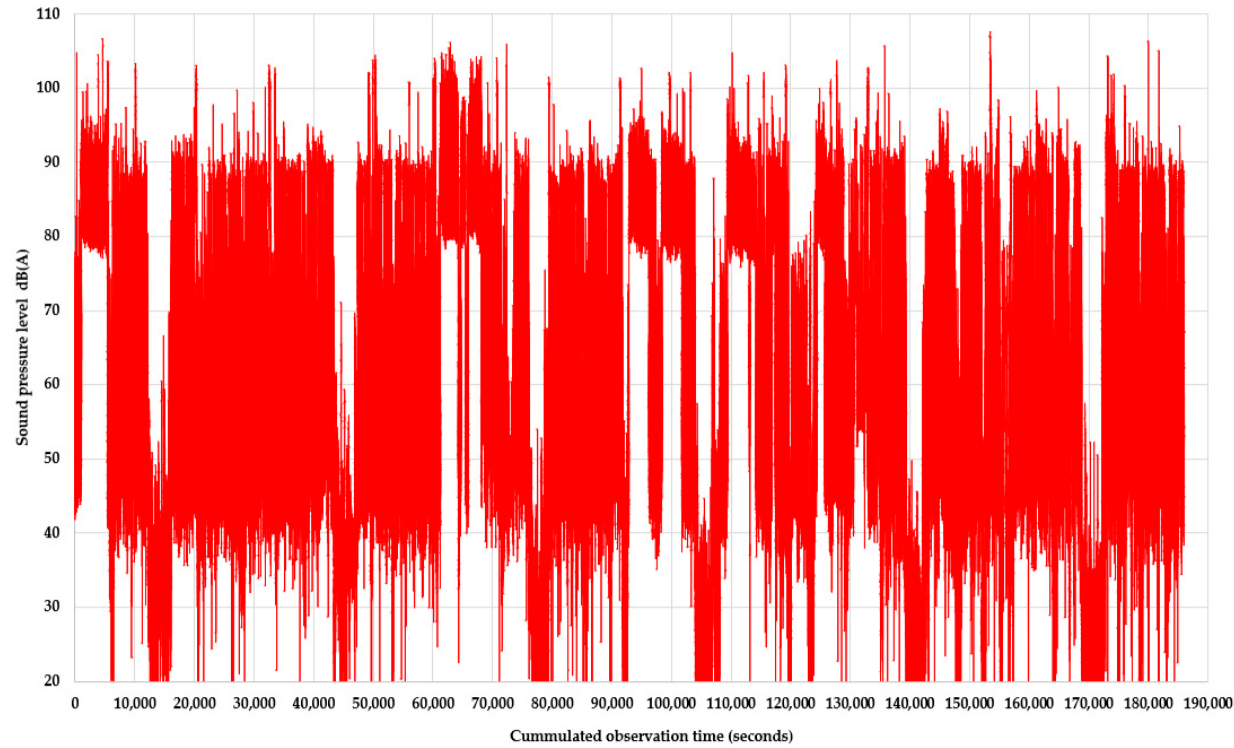
Figure 5. Variation in the time domain of the sound pressure level measured at 1 Hz for the six days of observation.